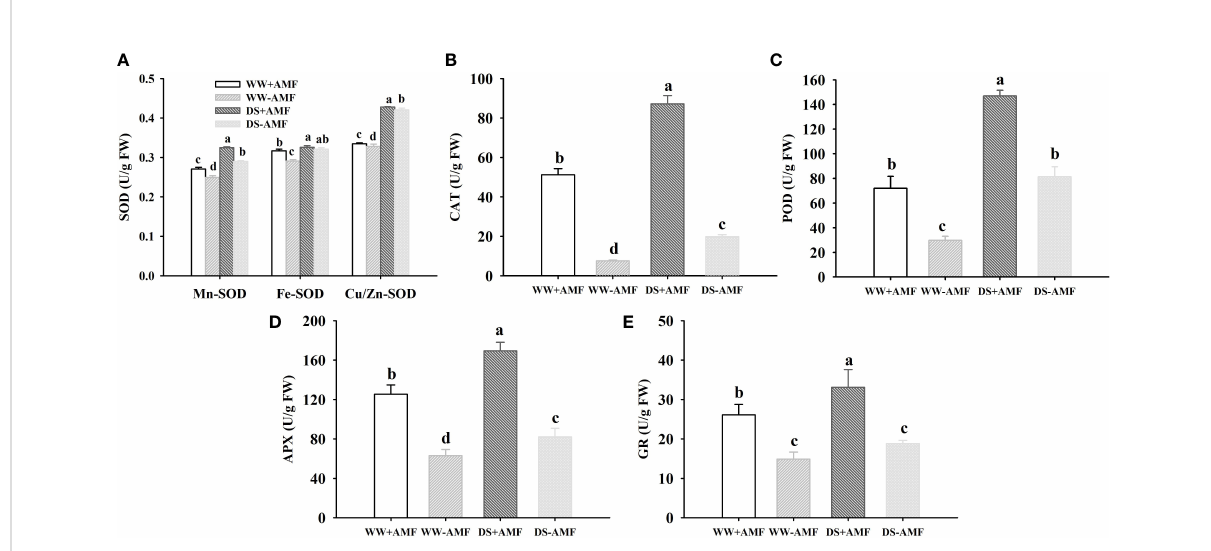
FIGURE 4 Effect of AMF ( Diversispora spurca ) on leaf superoxide dismutase (SOD) (A) , catalase (CAT) (B) , peroxidase (POD) (C) , ascorbate peroxidase (APX) (D) , and glutathione reductase (GR) (E) activities of walnut under well-watered (WW) and drought stress (DS). Data (means ± SD, n = 4) are signi fi cantly different ( P < 0.05), if followed by different letters above the bars.